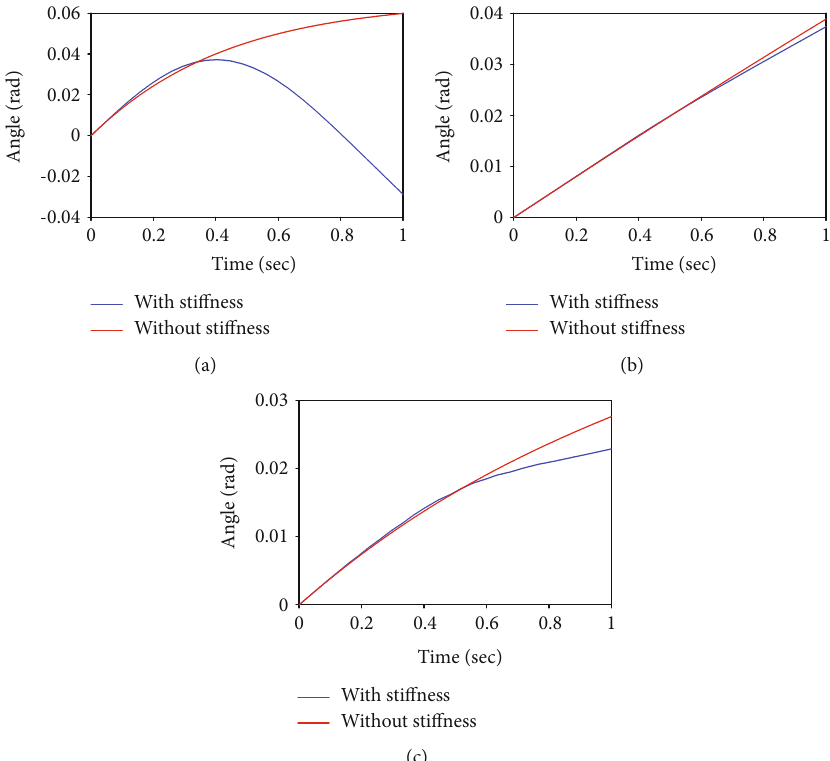
Figure 13: Attitude of the target satellite during identi fi cation: (a) X axis, (b) Y axis, and (c) Z